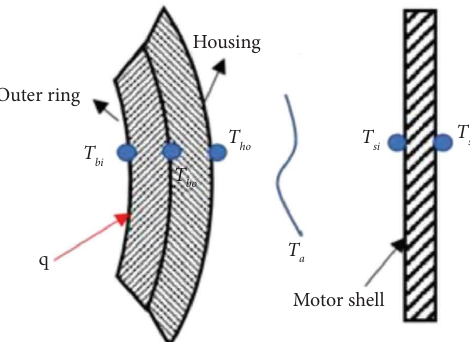
Figure 7: Simplifed fgure of heat exchange between bearing outer ring and motor